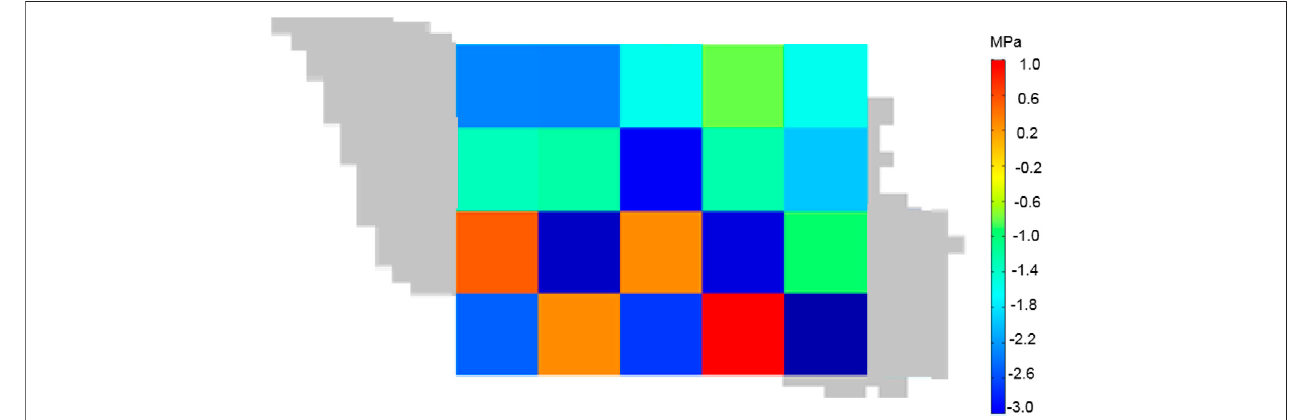
FIGURE 6 | Formation pressure change from November 2017 to April 2018.